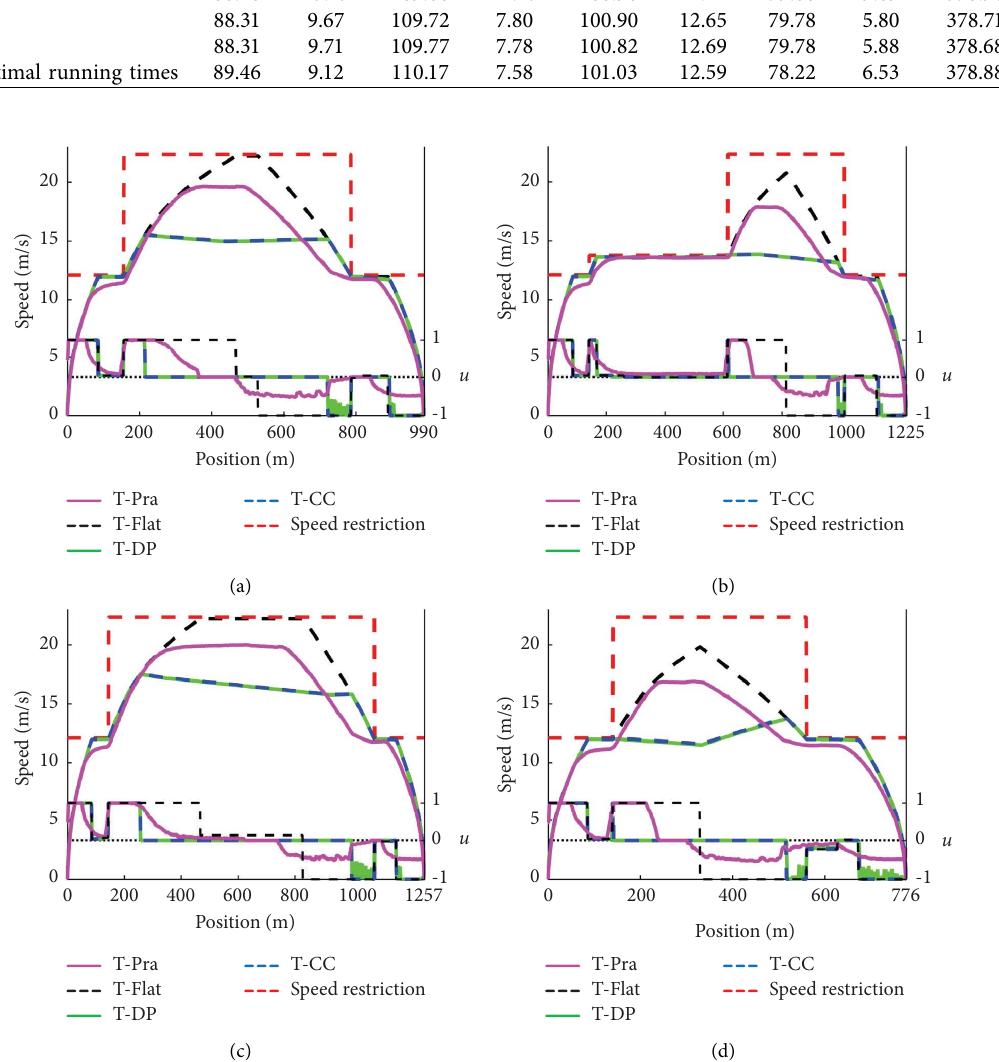
Figure 8: Te illustration of trajectories and control commands μ for four sections. (a) Section [ S [ S 3 , S 4 ]. (d) Section [ S 4 , S 5